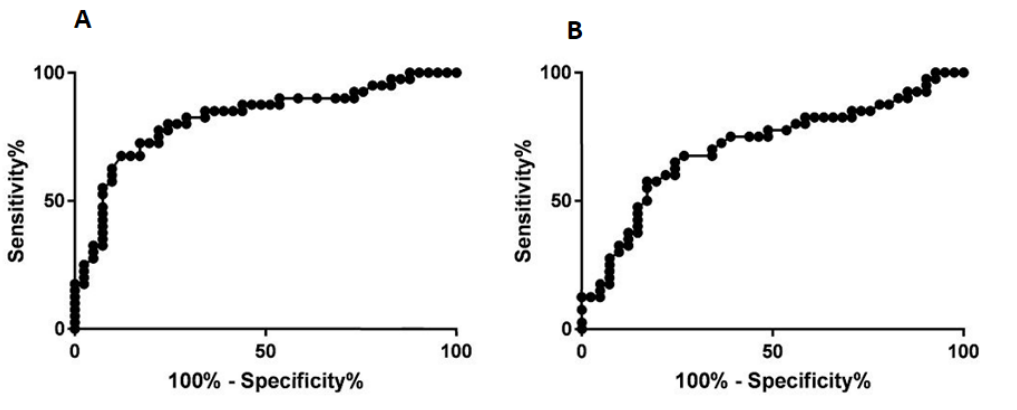
Figure 1: ROC curve of serum Hcy, folate in diagnosis of cognitive impairment in patients with Parkinson’s disease(A: ROC curve for serum Hcy; B:ROC curve for serum folate).